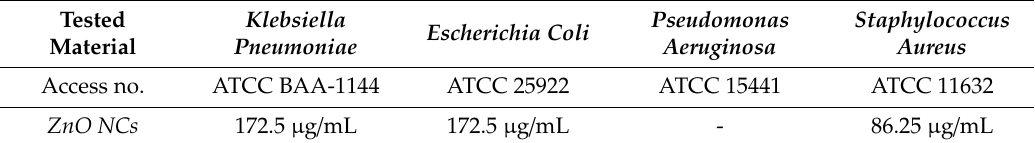
Table 1. Minimum inhibitory concentration (MIC) of the biologically synthesized ZnO NCs against tested